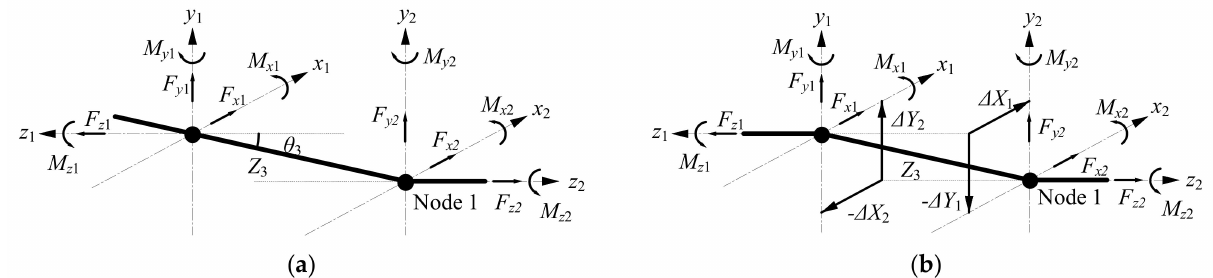
Figure A1. Analysis of misalignment geometry and force: ( a ) deflection angle of misalignment; ( b ) parallel of